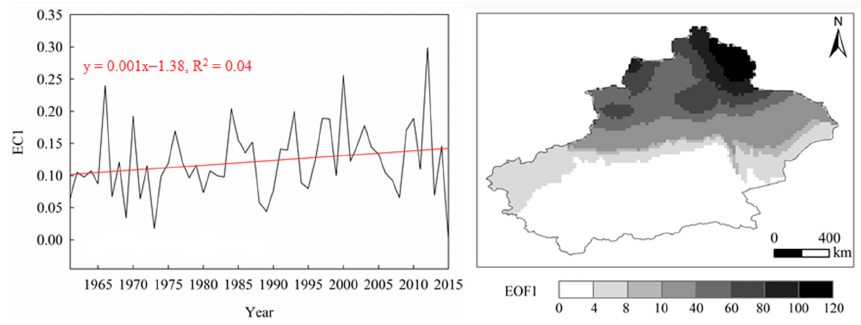
Figure 7. The annual EC1 and long-term mean EOF1 in Xinjiang.